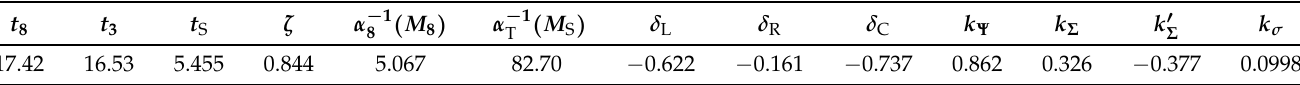
Table 3. Benchmark points used for the running of the gauge couplings in Figure 1. The top line corresponds to a parameter space point where δ i differ considerably whereas in the bottom line their absolute values are of the same order. Here, M i t i = log 10 GeV